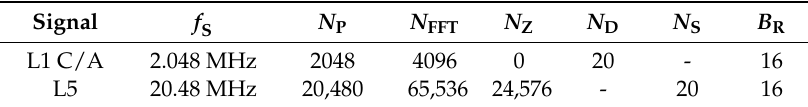
Table 3. Parameters independent of the integration time selected for Global Positioning System (GPS)